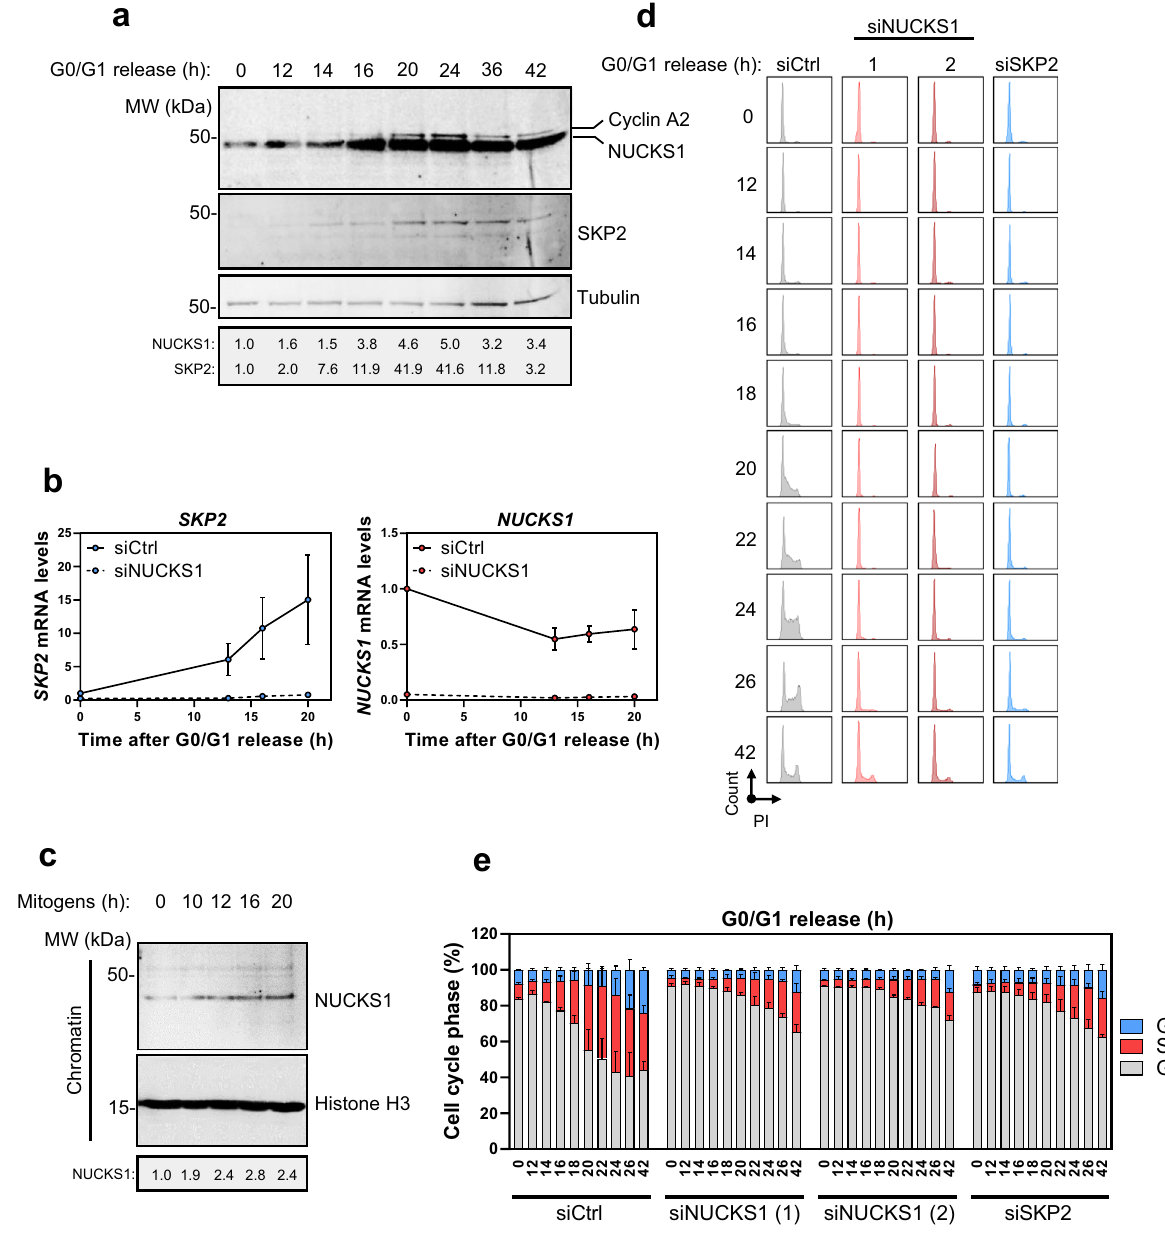
Fig. 2 NUCKS1 levels and chromatin-binding are induced in late G1 to promote SKP2 expression and G1/S progression. a Western blot in whole cell extracts of RPE1-hTERT cells synchronised to G0/G1 by 72 h contact inhibition ( t = 0) followed by re-plating at low density to release cells into S phase. Representative of 3 independent experiments. b RT-qPCR in NBE1-hTERT cells treated as in a . Data are presented as mean ± SEM from 3 independent experiments. c Western blot in the chromatin fraction of NBE1-hTERT cells starved of serum for 48 h ( t = 0) followed by mitogenic stimulation (15% FBS) for the indicated periods of time. Representative of 2 independent experiments. d PI cell cycle pro fi les of control, NUCKS1-, or SKP2-depleted RPE1- hTERT cells treated as in a . Representative of 3 independent experiments. e Quanti fi cation of d . Data are presented as mean ± SEM from 3 independent experiments. MW: molecular weight, kDa: kilodaltons, PI: propidium iodide. Source data are provided as a source data fi le.